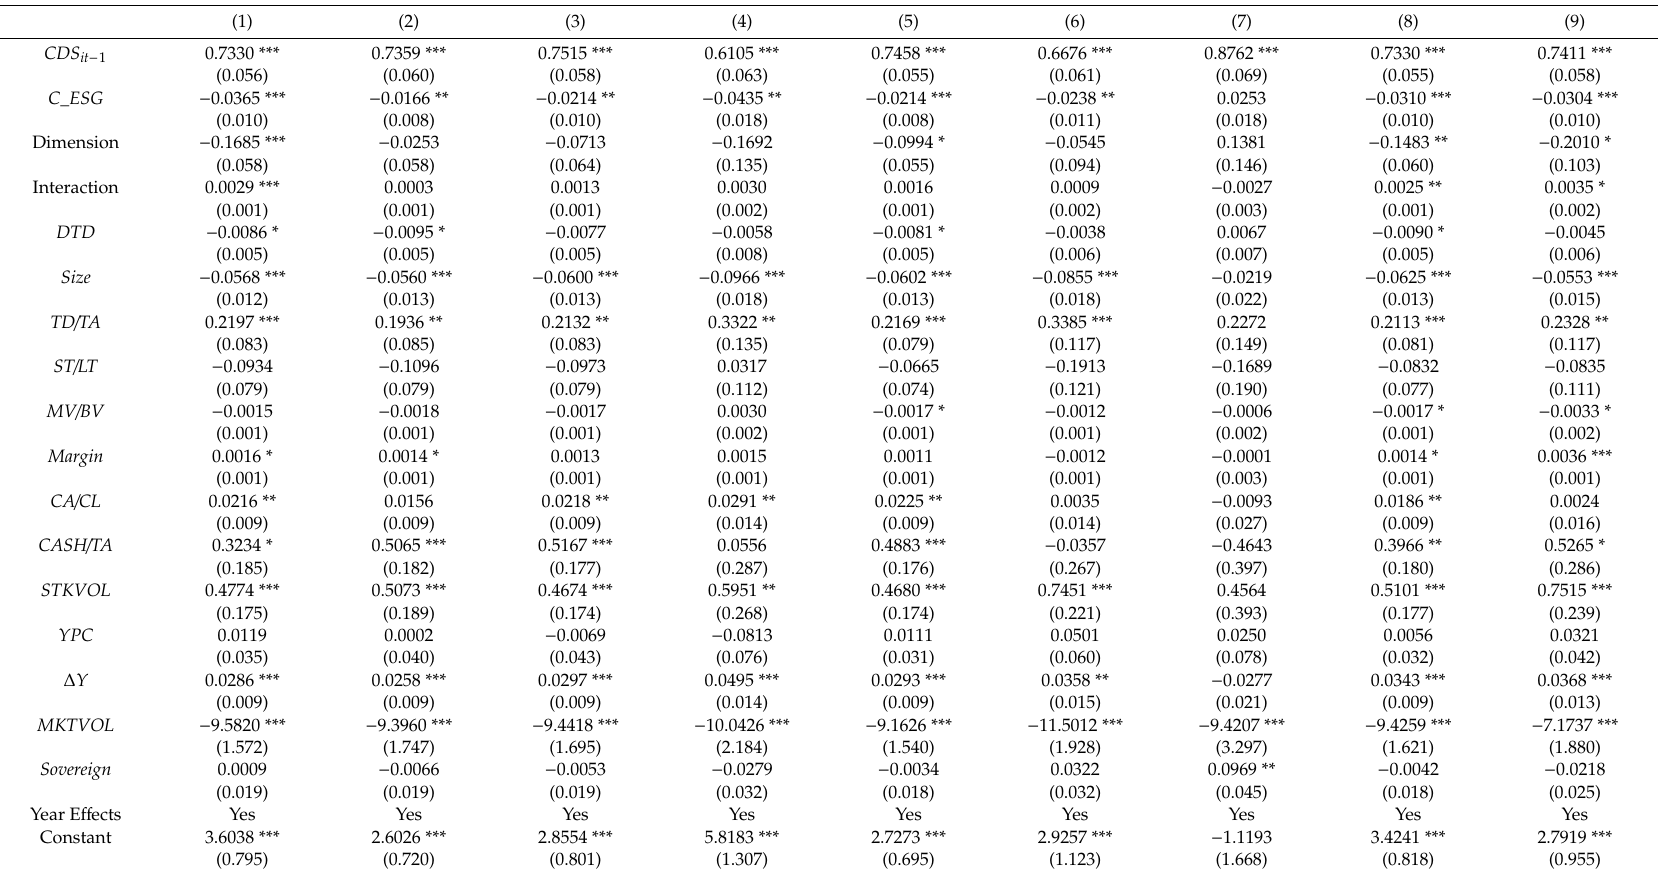
Table 5. System GMM estimation results for the e ff ects of corporate social performance (CSP) dimensions and their interaction with aggregate country sustainability on corporate default swap (CDS) spreads.